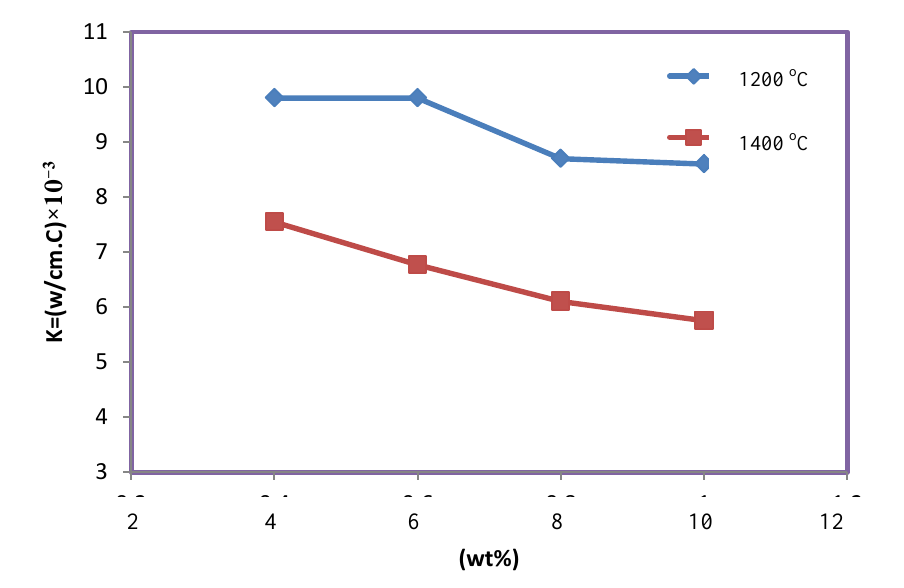
Fig. 7: Thermal conductivity of spinel MA with additives (TiO 1400 °